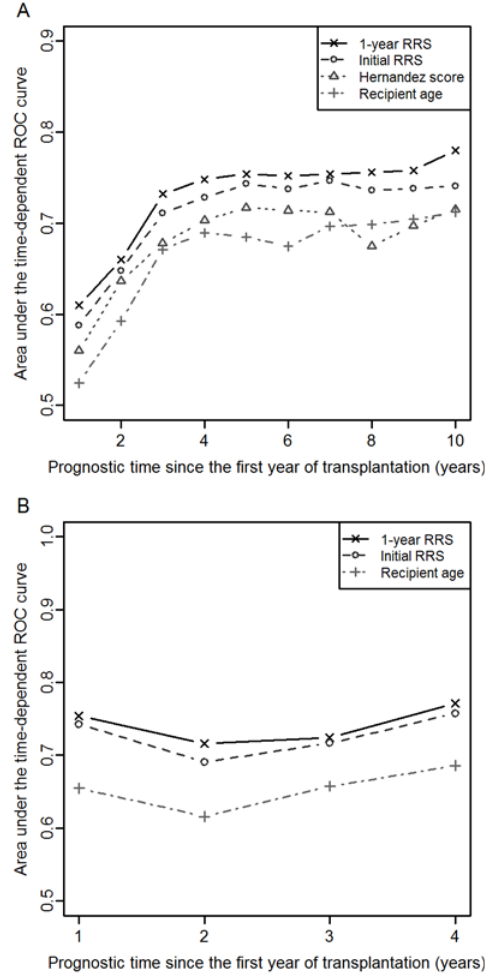
Fig 2. Area under time-dependent ROC curves according to prognostic time to evaluate the prognostic capacities of the different markers. (A) The analyses were based on the DIVAT validation sample (n = 1148). The 1-year updated RRS (black continuous line, 10-year AUC = 0.78, 95%CI = [0.69, 0.85]). The RRS (black dashed line, 10-year AUC = 0.74, 95%CI = [0.66, 0.80]). The score proposed by Hernandez et al. (grey dotted line, 10-year AUC = 0.71, 95%CI = [0.64, 0.78]). The recipient age (grey dashed-dotted line, 10-year AUC = 0.71, 95%CI = [0.64, 0.77]). (B) The analyses were based on the STCS cohort (n = 800). The 1-year updated RRS (black continuous line, 4-year AUC = 0.77, 95%CI = [0.68, 0.85]). The RRS (black dashed line, 4-year AUC = 0.76, 95%CI = [0.66, 0.83]). The recipient age (grey dashed- dotted line, 4-year AUC = 0.69, 95%CI = [0.61,